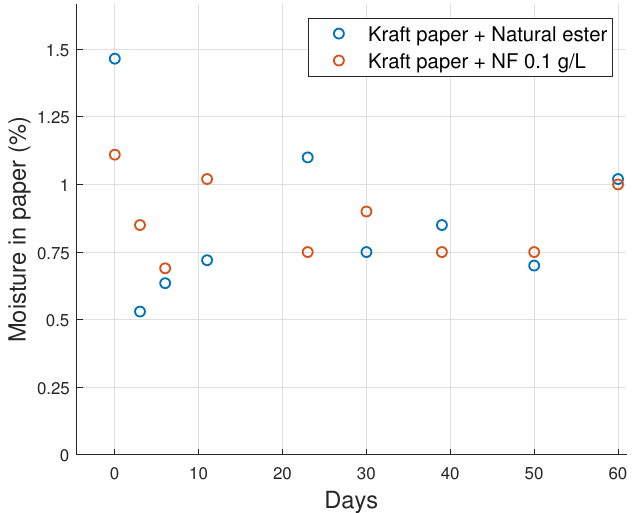
Figure 8. Moisture content in cellulose vs. aging time for NF- and NE-based